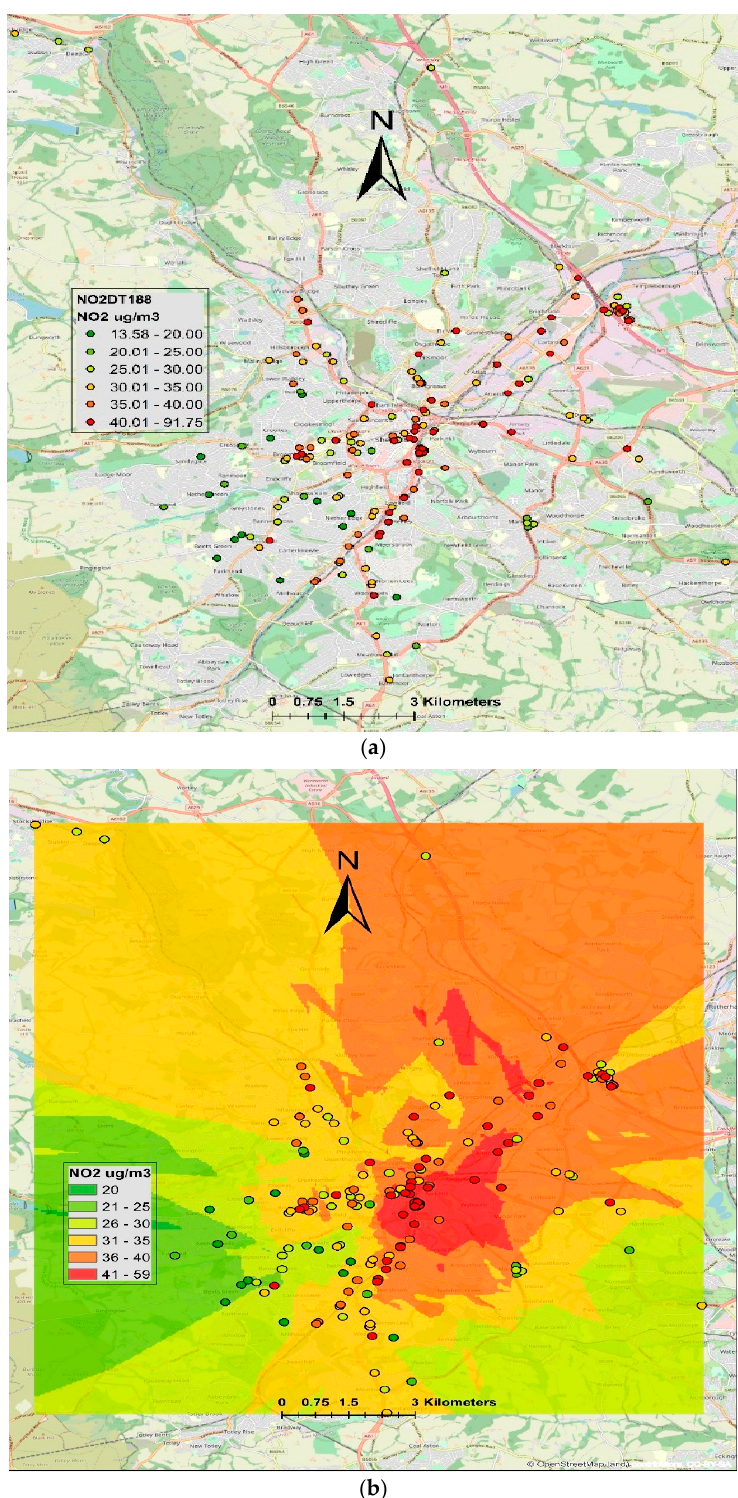
Figure 4. Showing point and interpolated NO 2 levels from DT network: ( a ) NO 2 concentrations ( µ g/m 3 ) from DT, and ( b ) interpolated NO 2 concentrations ( µ g/m 3 ) using ordinary